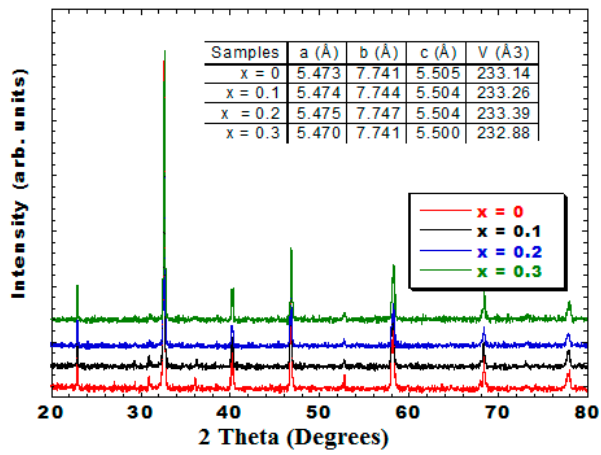
Figure 1. XRD patterns for La 0.8 Ca 0.2 Mn 1 − x Co x O 3 (x = 0, 0.1, 0.2, 0.3). Inset table: cell parameters.